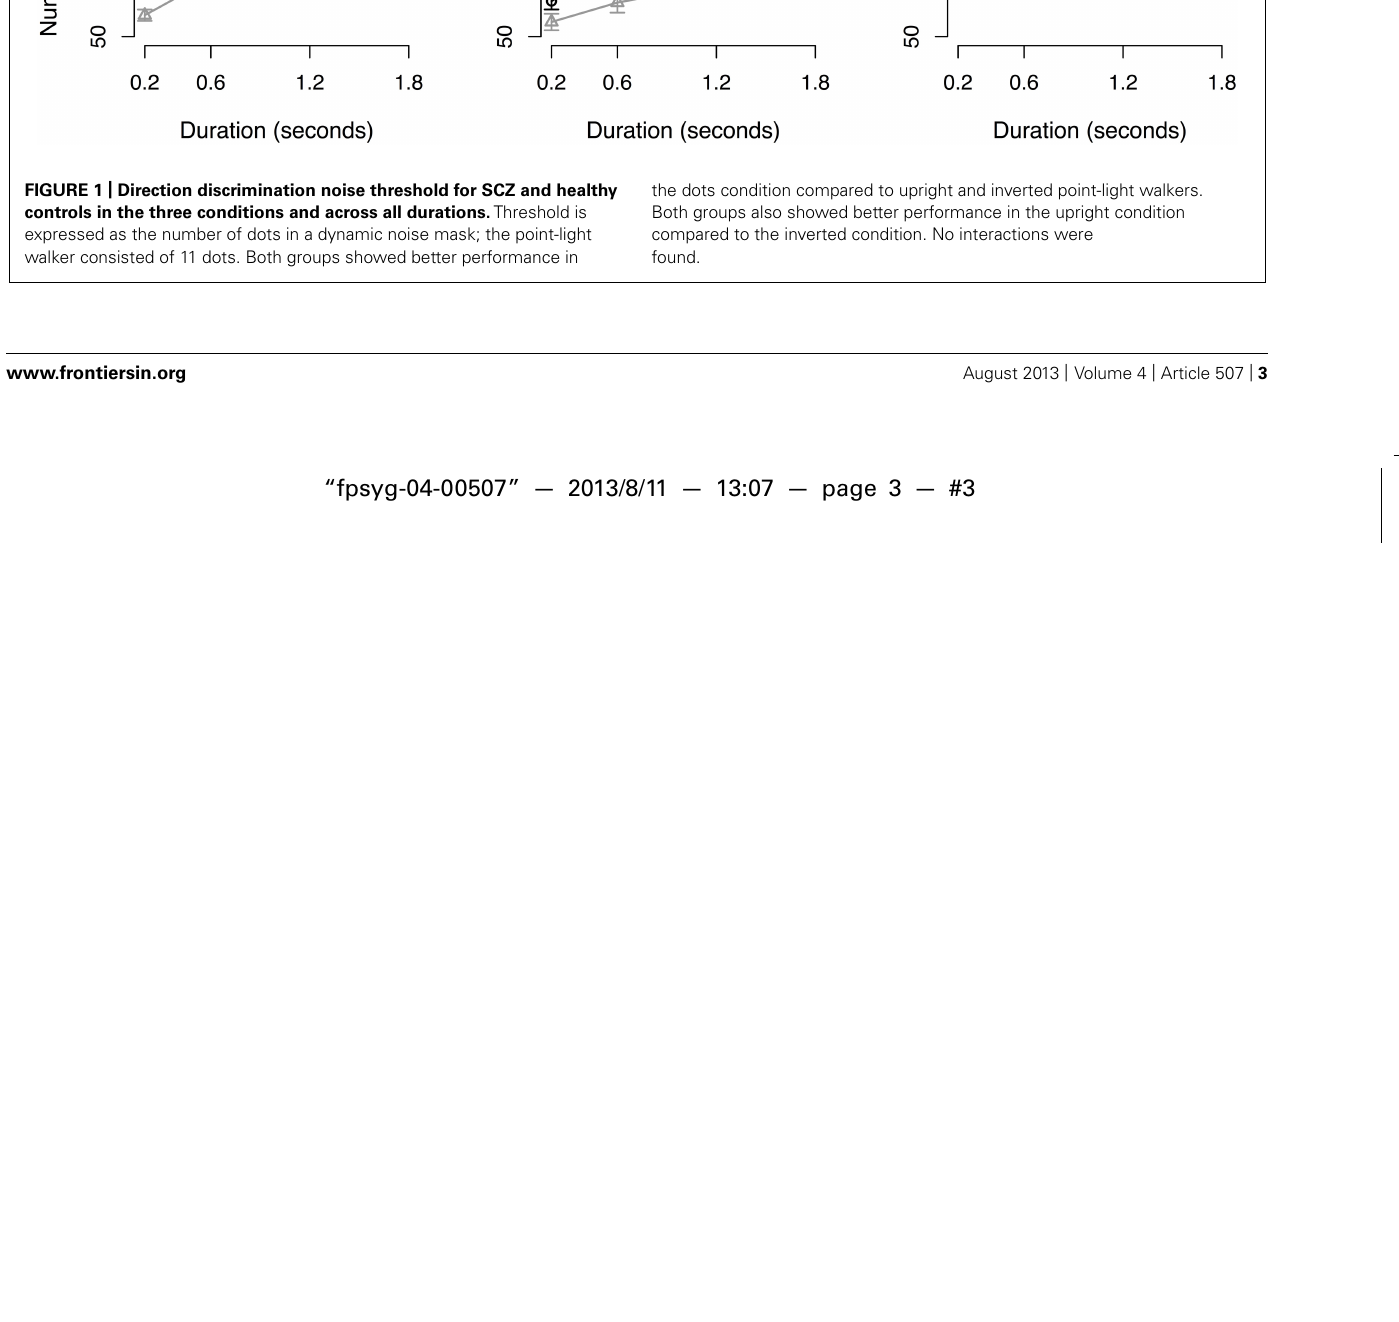
the dots condition compared to upright and inverted point-light walkers. Both groups also showed better performance in the upright condition compared to the inverted condition. No interactions were